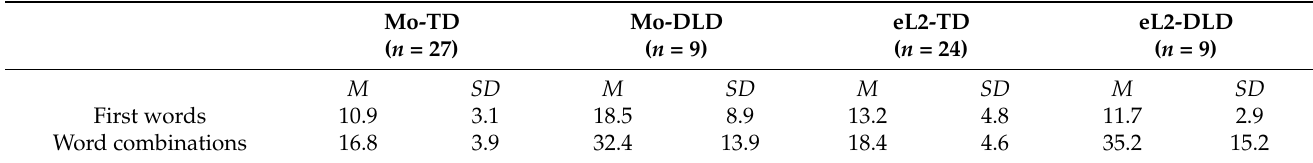
Table 2. Age at the emergence of first words and multiword utterances, in months.